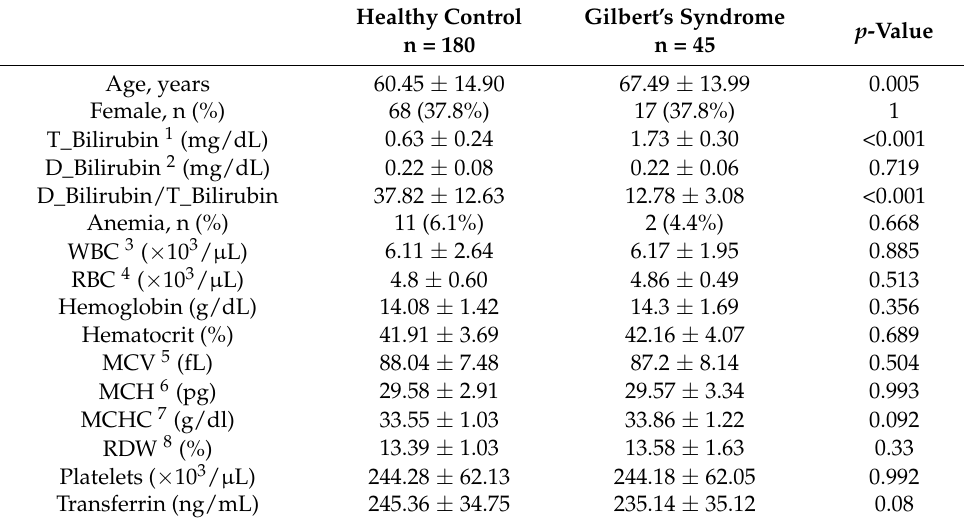
Table 1. Baseline characteristics of 225